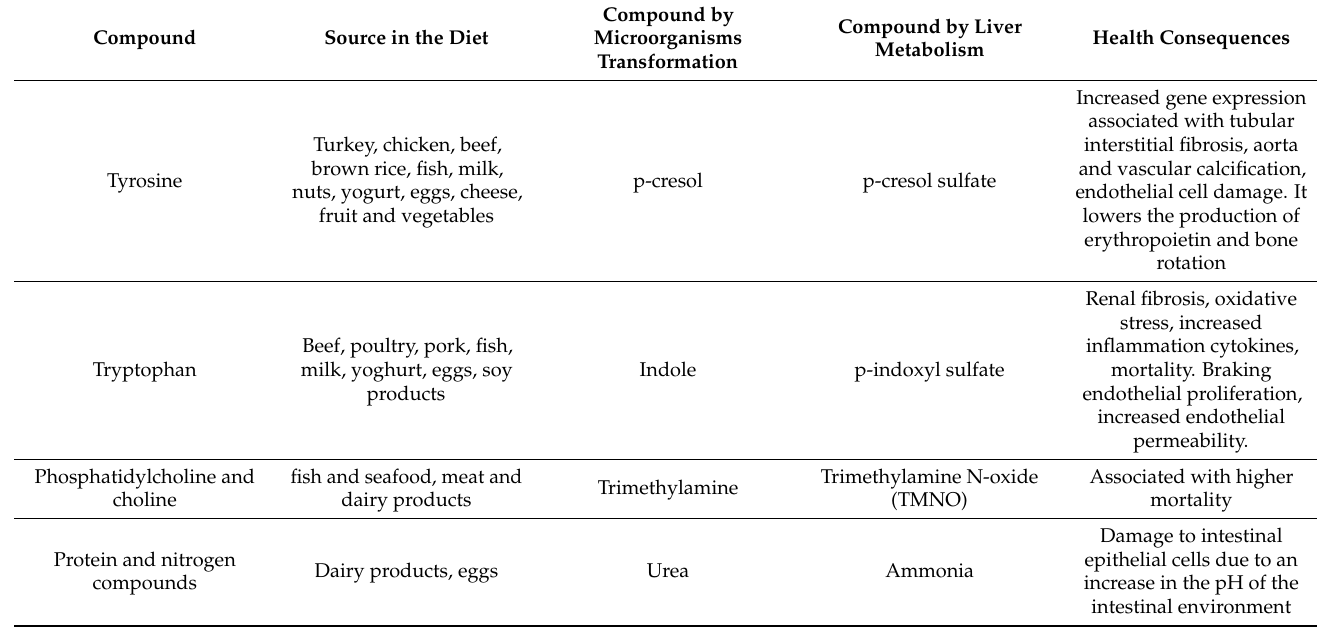
Table 2. Formation and health consequences of selected uremic toxins (based on [70–77]).